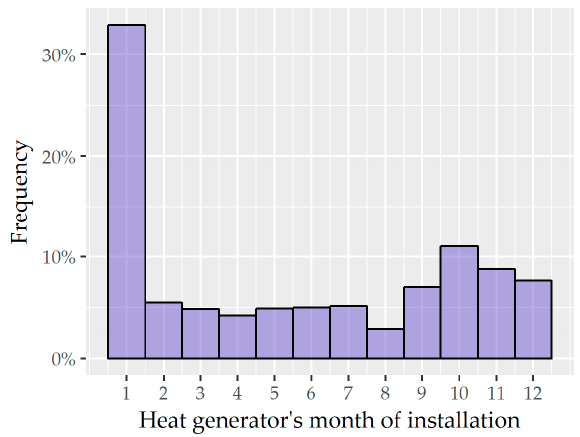
Figure 1. Example of data anomaly: number of heat generators installed per month.